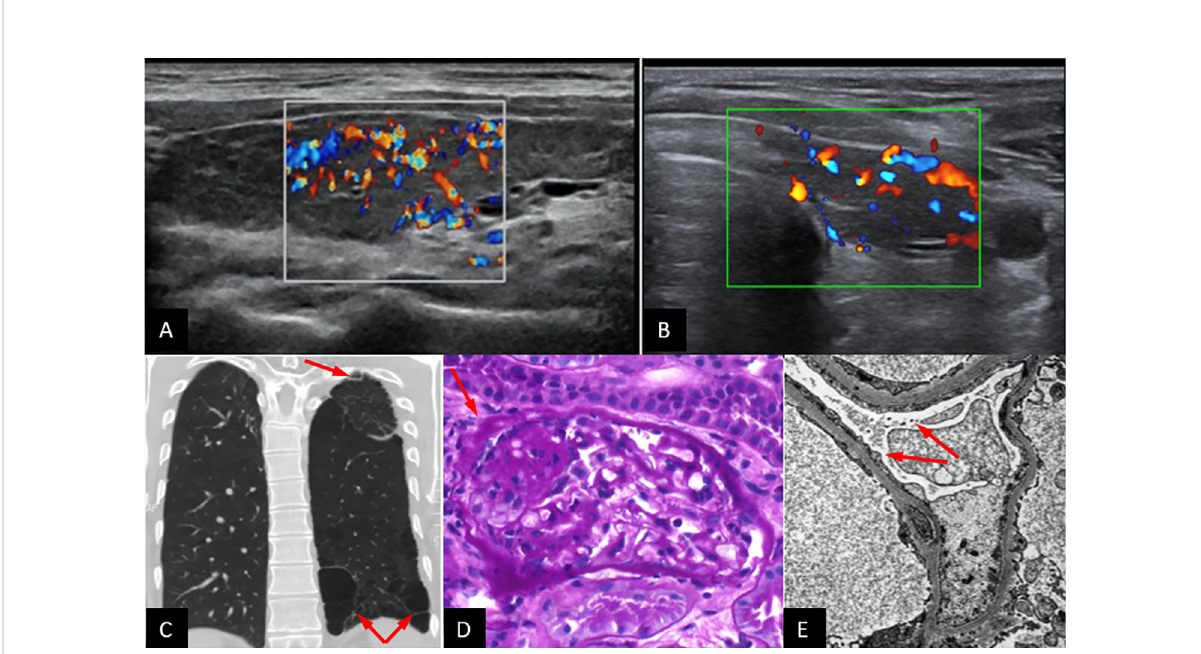
FIGURE 2 Thyroid ultrasound showing normal-sized, inhomogeneously structured, hypervascularized thyroid and connective tissue alterations, typical signs of Hashimoto ’ s thyroiditis, in P1 (A) and P2 (B) . Chest CT of P1. Arrows indicate basal paraseptal bullae, paraseptal emphysema cranially, and dextrally. Apical callus and spread micronodules (C) . Kidney biopsy, PAS staining: a sclerotized region with scarring in the glomerulus